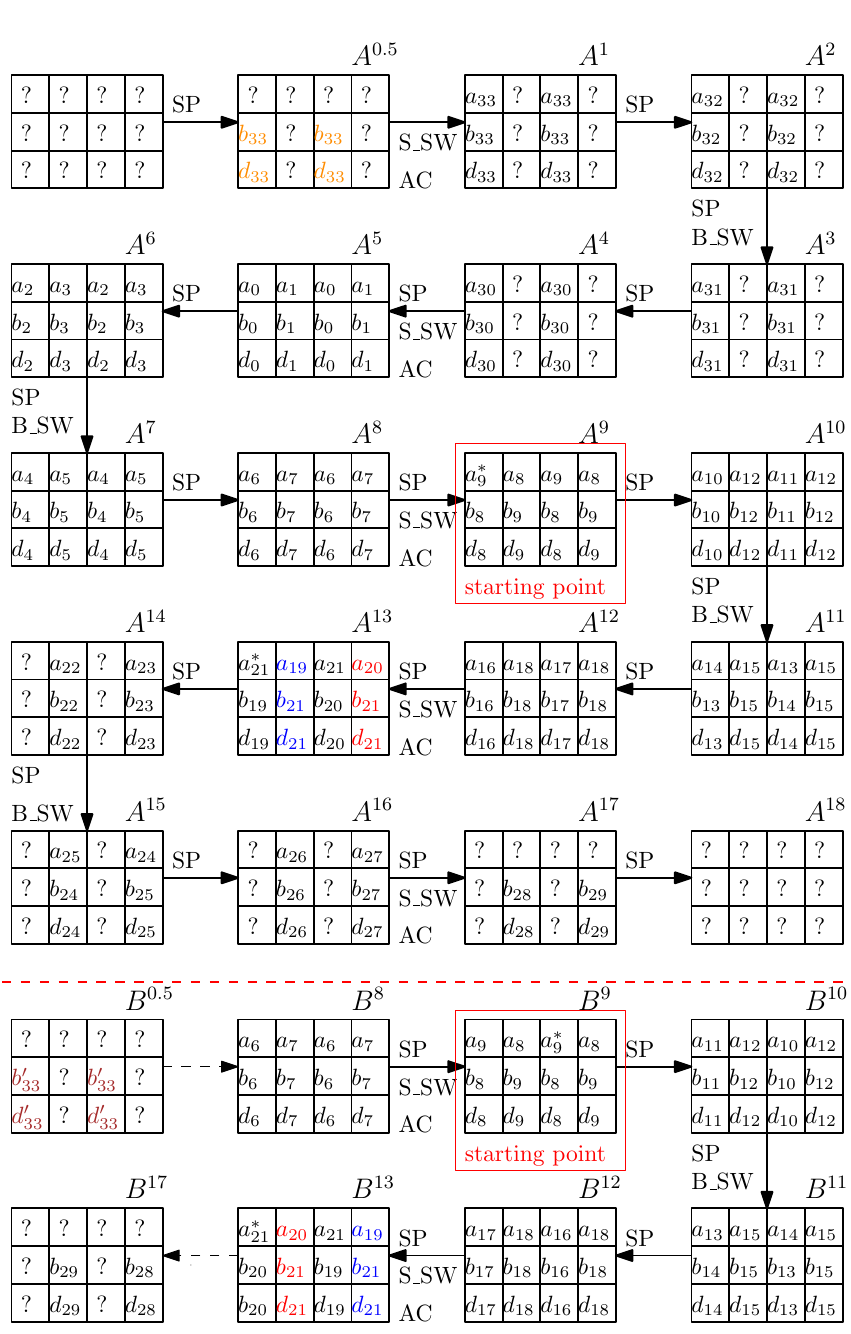
Figure 5: Evolution of the internal difference for ( A 9 , B 9